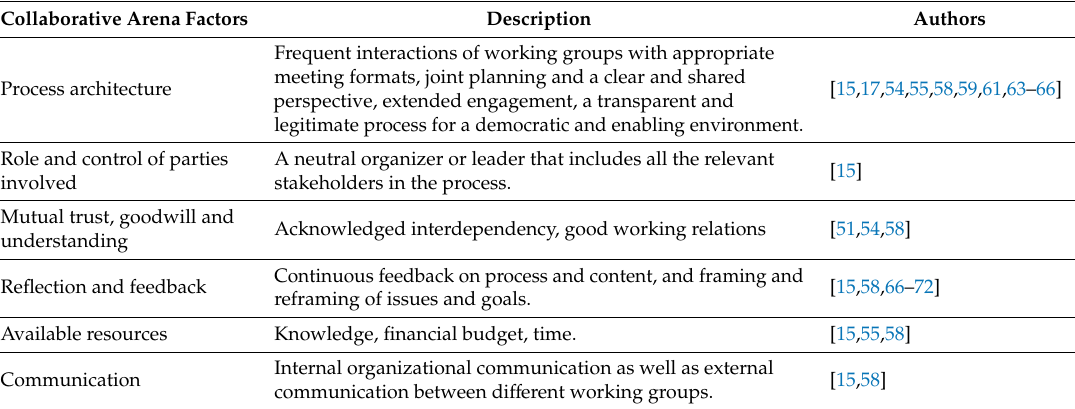
Table 2. Collaborative arena factors influencing the social learning